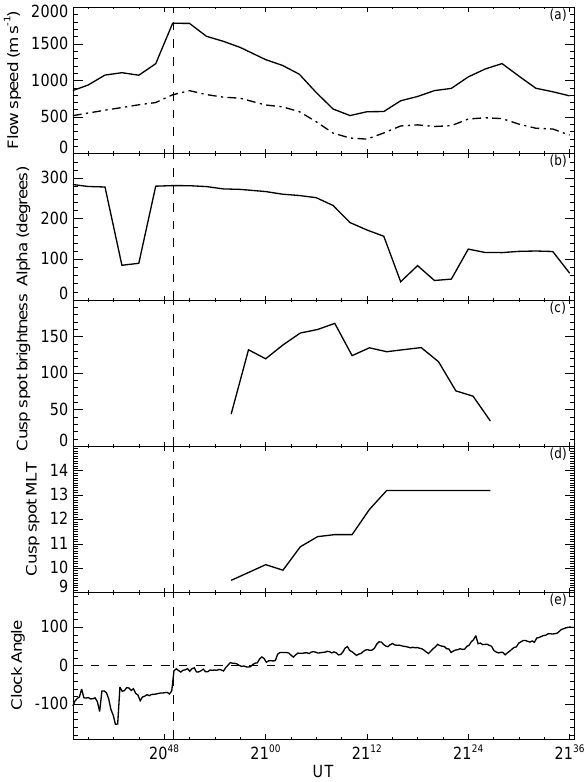
Fig. 10. (a) The maximum and mean velocity of ionospheric flow measured by the SuperDARN radars within a sector 9.5–14.5 MLT and 65–75 ◦ magnetic latitude between 20:36 and 21:36 UT (b) The angle of the maximum velocity vector to North, clockwise in de- grees (c) The brightness of the cusp spot (d) The MLT of the cusp spot (e) The clock angle measured by ACE, lagged to the magne- topause. The vertical dashed line represents the time at which the reconnection is thought to have